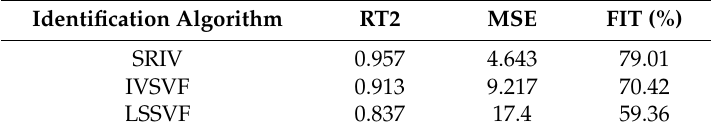
Table 5. Evaluation parameters under different identification algorithms.